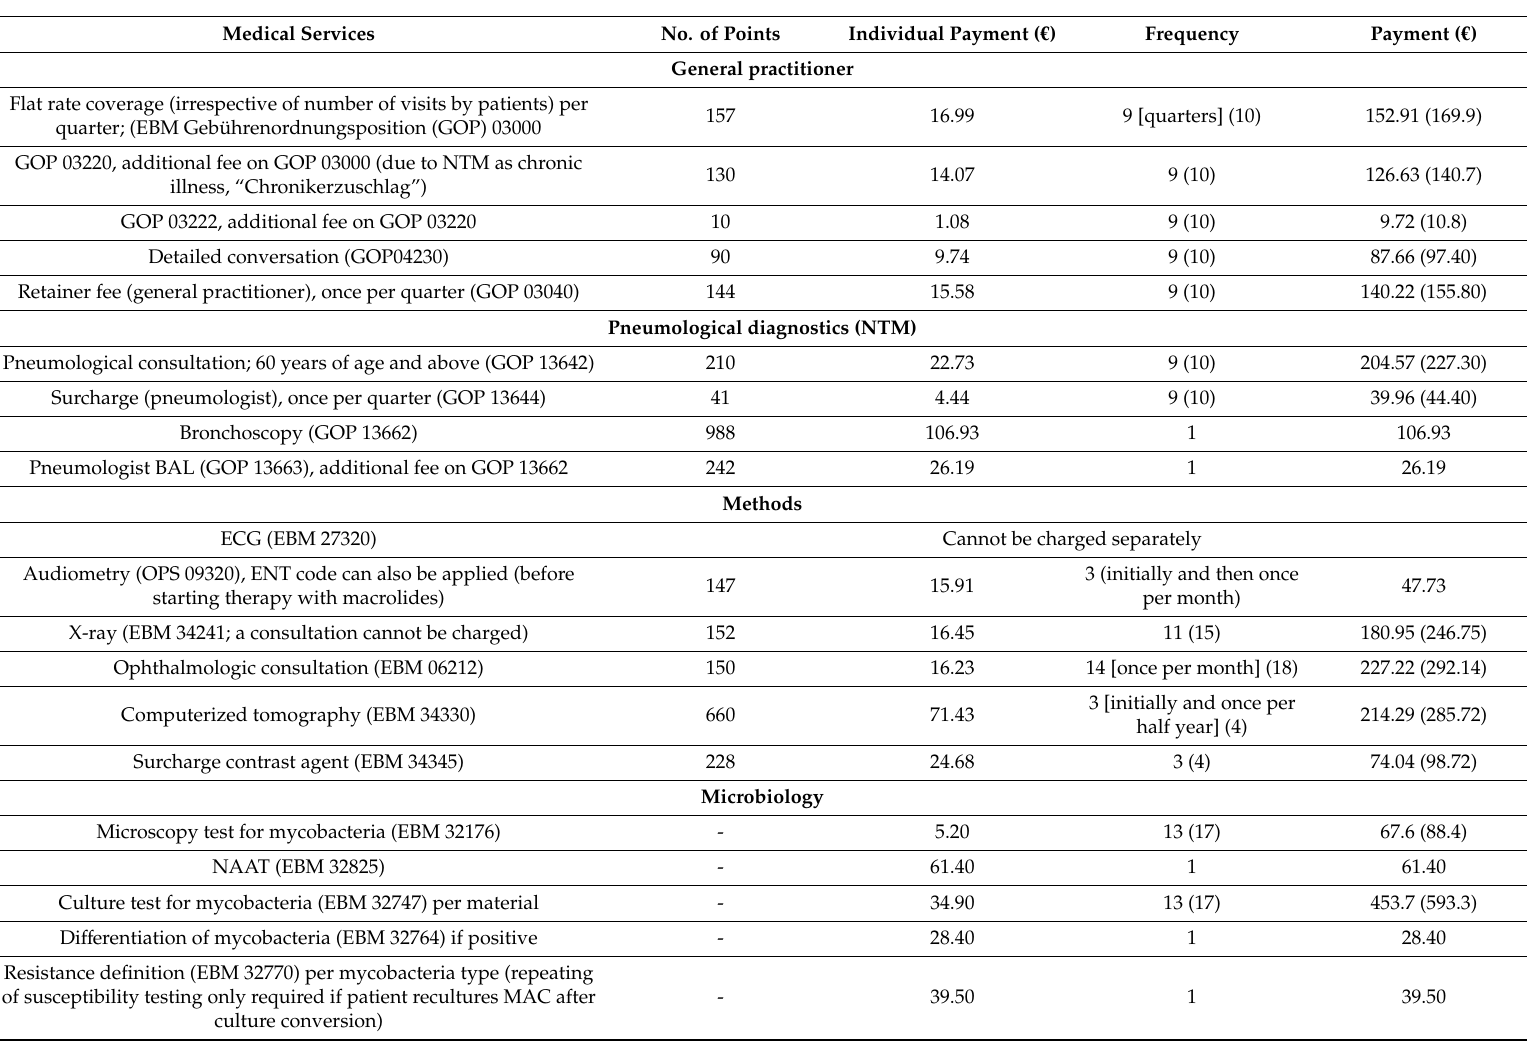
Table 4. German statutory health insurance community (SHI) costs of diagnosing and monitoring pulmonary NTM in the outpatient setting. Medical Services No. of Points Individual Payment ( € ) Frequency Payment ( € ) General